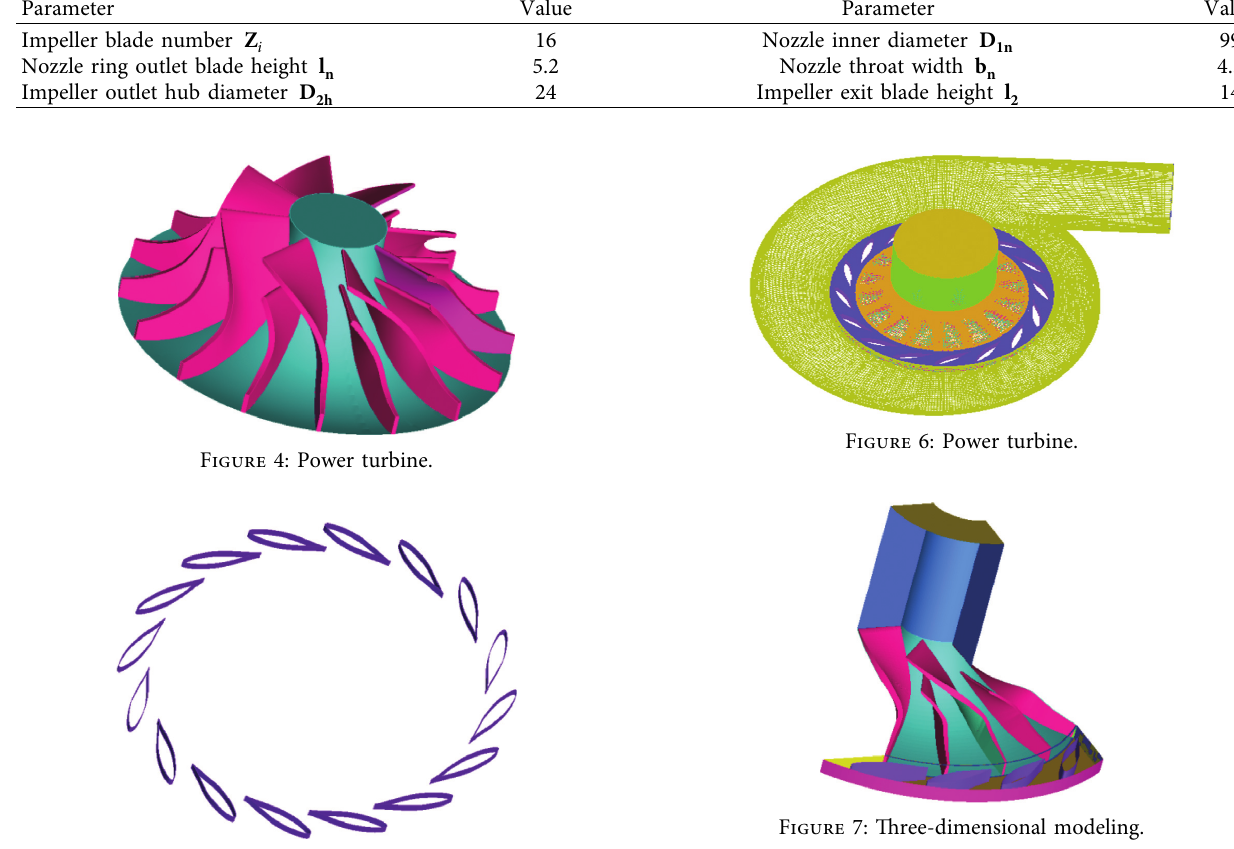
Figure 5: Variable area nozzle.